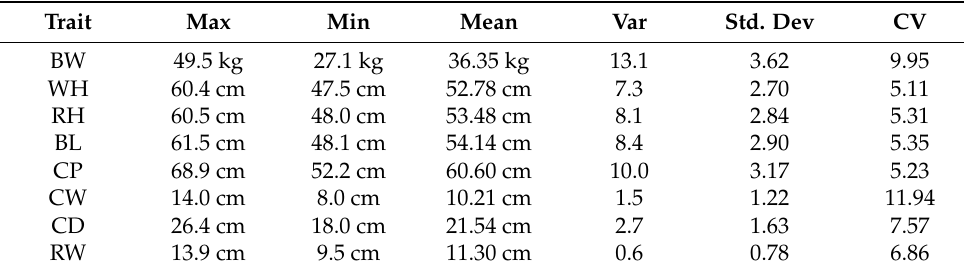
Table 1. Descriptive GLM statistics for body weight and body conformation traits in Karachai goats at age 8 months.